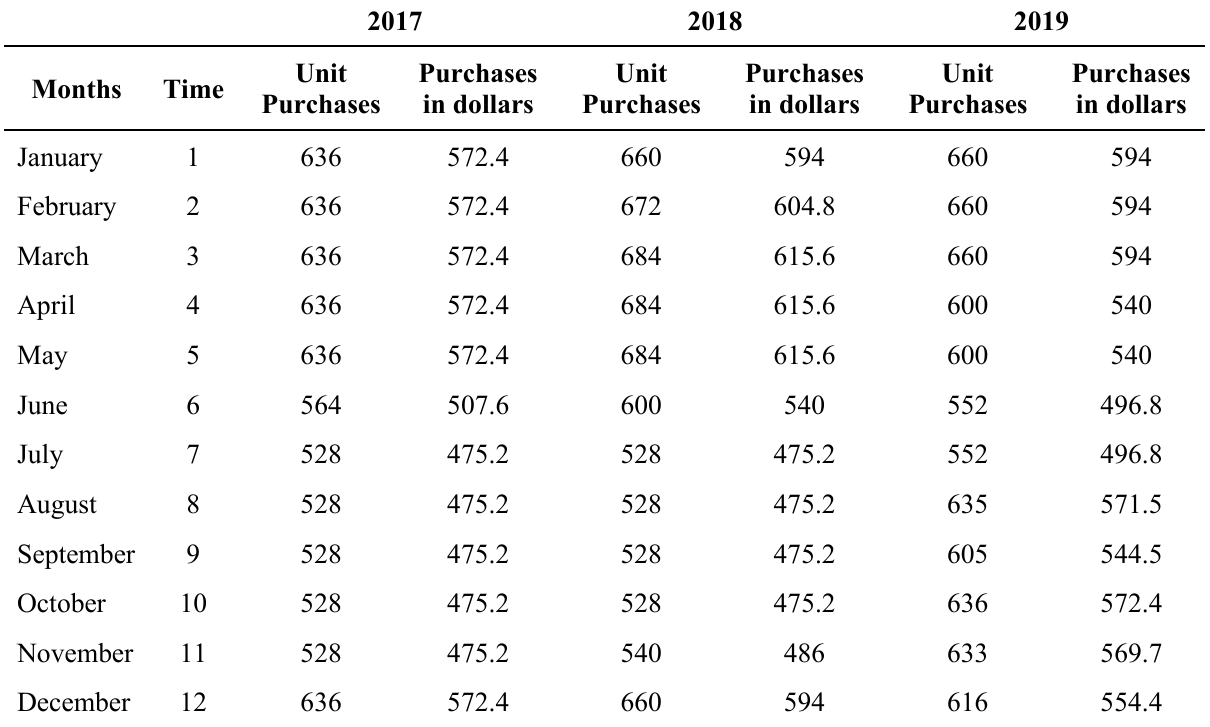
Table 2. Distribution of ProductPurchases